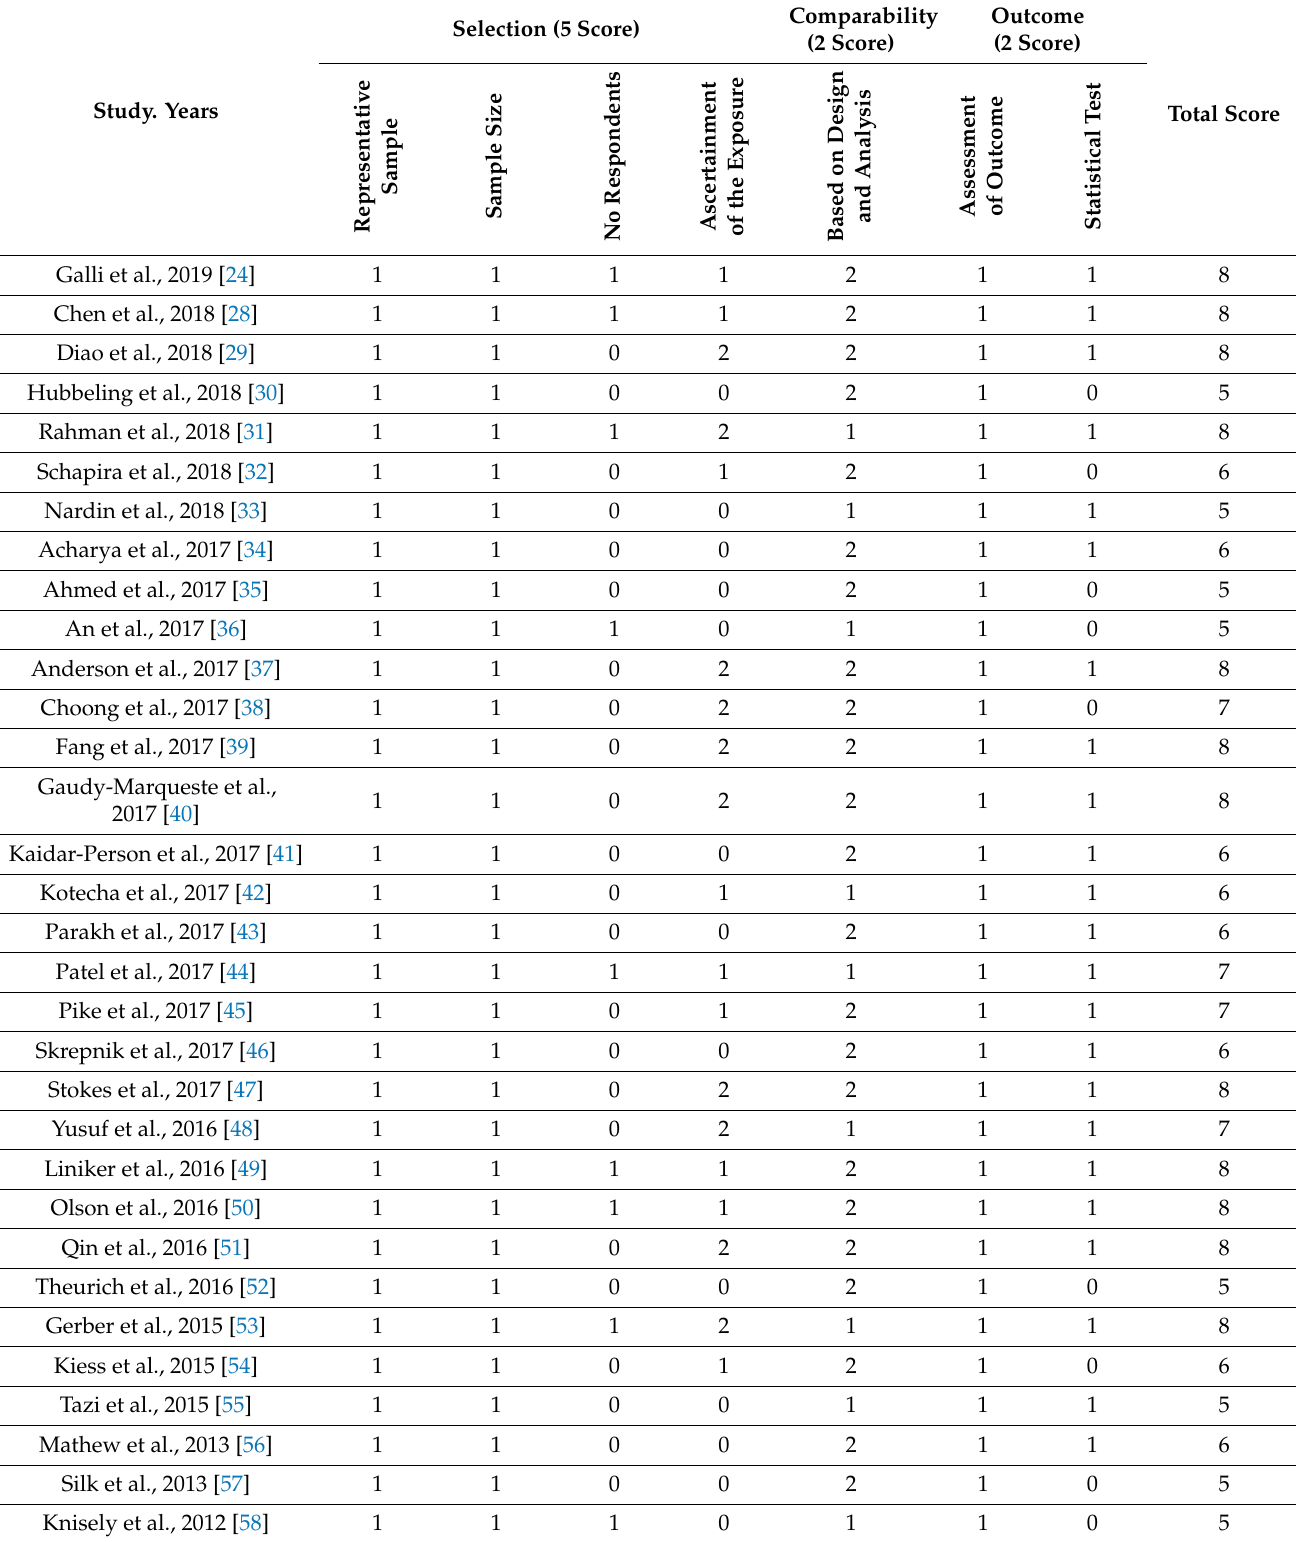
Table 3. Risk of bias